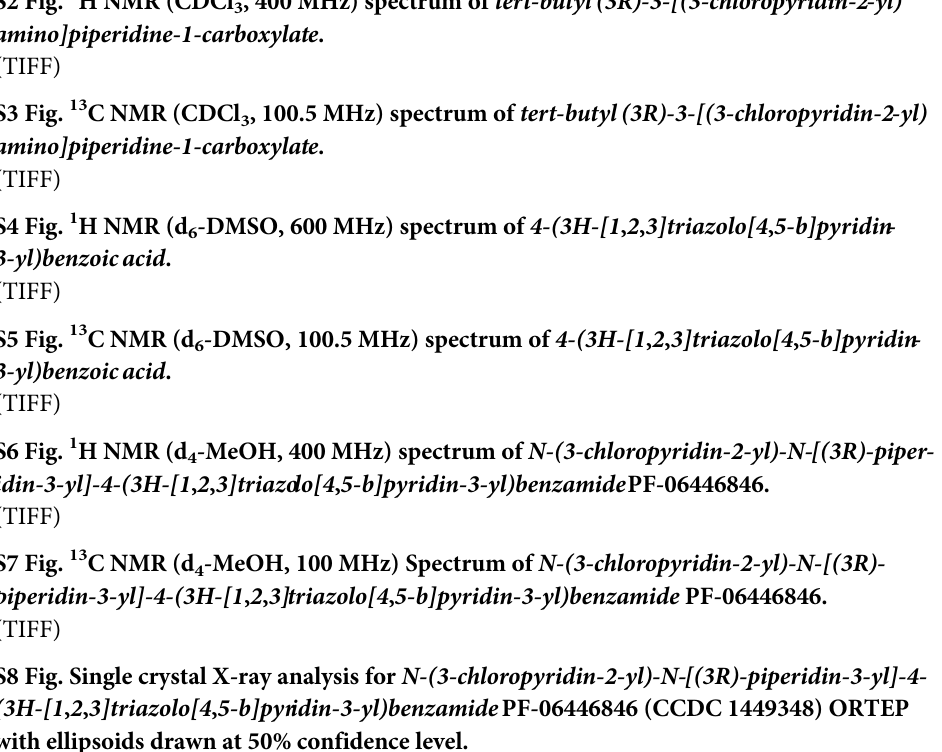
fold increments. (B) Representative SDS-PAGE of total lysates of Huh7 cells labelled with 35 S Met/Cys in the presence of varying concentrations of PF-06446846. Cycloheximide (CHX) was used as a control. (C) Quantitation 35 S incorporation by densitometry, error bars repre- sent one standard deviation of three replicates. (D) Translation inhibition curves for PCSK9 (1–35)-luciferase (grey circles) and luciferase alone (black squares) in HeLa-derived cell-free translation reactions. (E) Nucleotide and amino acid sequences of constructs shown in Fig 1C. (TIFF) S2 Fig. 1 H NMR (CDCl , 400 MHz) spectrum of tert-butyl (3R)-3-[(3-chloropyridin-2-yl) 3 amino]piperidine-1-carboxylate . (TIFF) S3 Fig. 13 C NMR (CDCl , 100.5 MHz) spectrum of tert-butyl (3R)-3-[(3-chloropyridin-2-yl) 3 amino]piperidine-1-carboxylate . (TIFF) S4 Fig. 1 H NMR (d -DMSO, 600 MHz) spectrum of 4-(3H-[1 , 2 , 3]triazolo[4 , 5-b]pyridin- 6 3-yl)benzoicacid . (TIFF) S5 Fig. 13 C NMR (d -DMSO, 100.5 MHz) spectrum of 4-(3H-[1 , 2 , 3]triazolo[4 , 5-b]pyridin- 6 3-yl)benzoicacid . (TIFF) S6 Fig. 1 H NMR (d -MeOH, 400 MHz) spectrum of N-(3-chloropyridin-2-yl)-N-[(3R)-piper- 4 (TIFF) S7 Fig. 13 C NMR (d -MeOH, 100 MHz) Spectrum of N-(3-chloropyridin-2-yl)-N-[(3R)- 4 piperidin-3-yl]-4-(3H-[1 , 2 , 3]triazolo[4 , 5-b]pyridin-3-yl)benzamide PF-06446846. (TIFF) S8 Fig. Single crystal X-ray analysis for N-(3-chloropyridin-2-yl)-N-[(3R)-piperidin-3-yl]-4- (3H-[1 , 2 , 3]triazolo[4 , 5-b]pyridin-3-yl)benzamide PF-06446846 (CCDC 1449348) ORTEP with ellipsoids drawn at 50% confidence level. (TIFF) S9 Fig. PF-06446846 effects on global protein synthesis and secretion. (A-D), Stable isotope labelling by amino acids in cell culture (SILAC) analysis of Huh7 cellular secretome after (A,B) 4-hour and (C,D) 16-hour treatment with 0.25 μM (A,C) or 1.25 μM (B,D) PF-06446846. (E-H), SILAC analysis of the cellular fraction from the experiments shown in panels a-d respectively. Ribosome profiling hits that are detected in the SILAC data are highlighted in red and labelled. (TIFF) S10 Fig. PF-06446846-sensitivity of PCSK9 mutations. (A) General schematic of mRNA constructs used to program cell-free translation reactions. Sites of mutations are in red and spacer residues are in orange. (B) Constructs, sequences and PF-06446846 sensitivity of PCSK9 mutants. Sequences are colored as in a, with the vector encoded residues in grey for the luciferase construct. Note that PCSK9 residues 34 are 35 are the same as luciferase resides 2 and 3. All error bars represent one standard deviation of three replicates. (C-F), Inhibitory activity of PF-06446846 in (C) Rabbit Reticulocyte Lysate (RRL) (D) Wheat Germ (E)